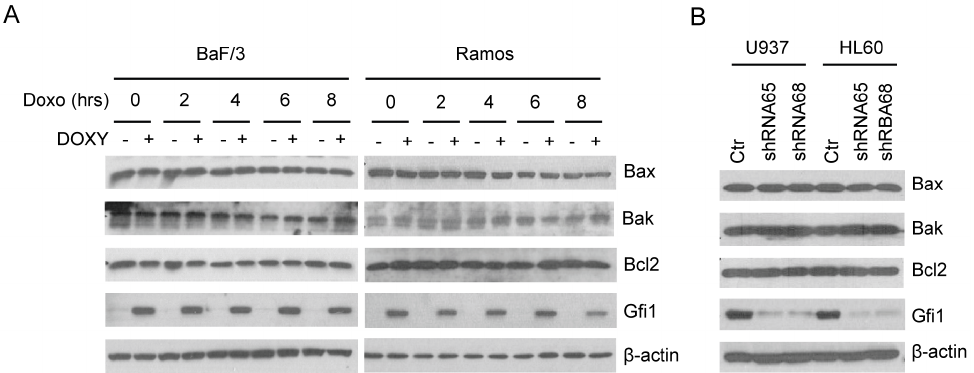
Figure 9. Gfi1 has no significant effect on the expression of Bax, Bak and Bcl-2. (A) Ba/F3 and Ramos cells transduced with the inducible Gfi1-expressing lentiviral construct were preincubated with Doxy (1 m g/ml) for 24 hrs and then treated with Doxo (100 ng/ml) for times as indicated. The expression of Gfi1 and the Bcl-2 family members as indicated was examined by Western blot analysis. (B) The levels of the Bcl-2 family members in control and GFI1 knocked down U937 and HL-60 cells were examined by Western blot